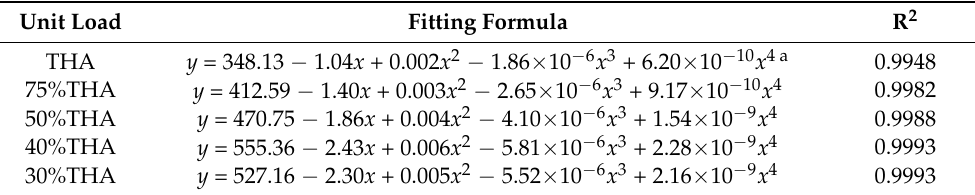
Table 7. The fitting formula of C per with flue gas temperature under different